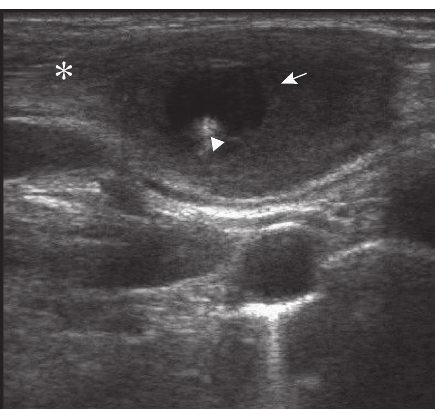
Figure 1: A 20-year-female who presented with gradual neck swelling and mild pain for 4 months. Sagittal grayscale ultraso- nography image showing well-defined thick-walled cystic lesion (arrow) in the intramuscular plane in the distal SCM (asterisk) with eccentric hyperechoic foci (arrowhead) within the cavity and surrounding edematous changes.